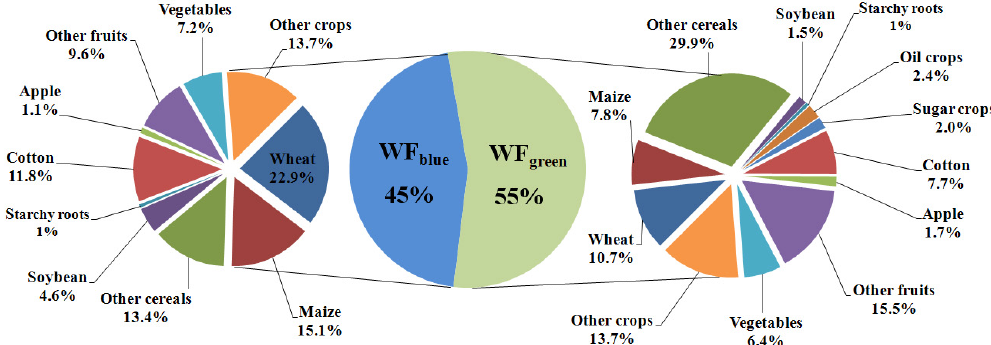
Fig. 4. Green and blue water footprint (WF green and WF blue ) of crop production within the HRB over